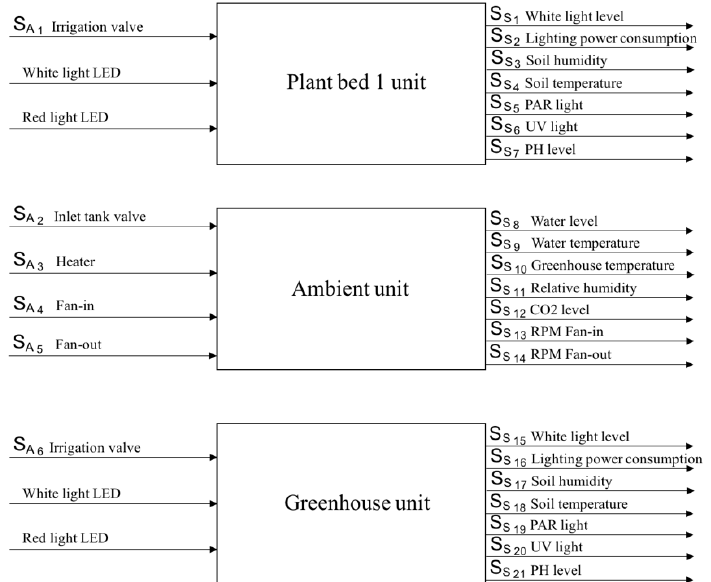
Figure 10. Description of the system units. Table 1. System components description.